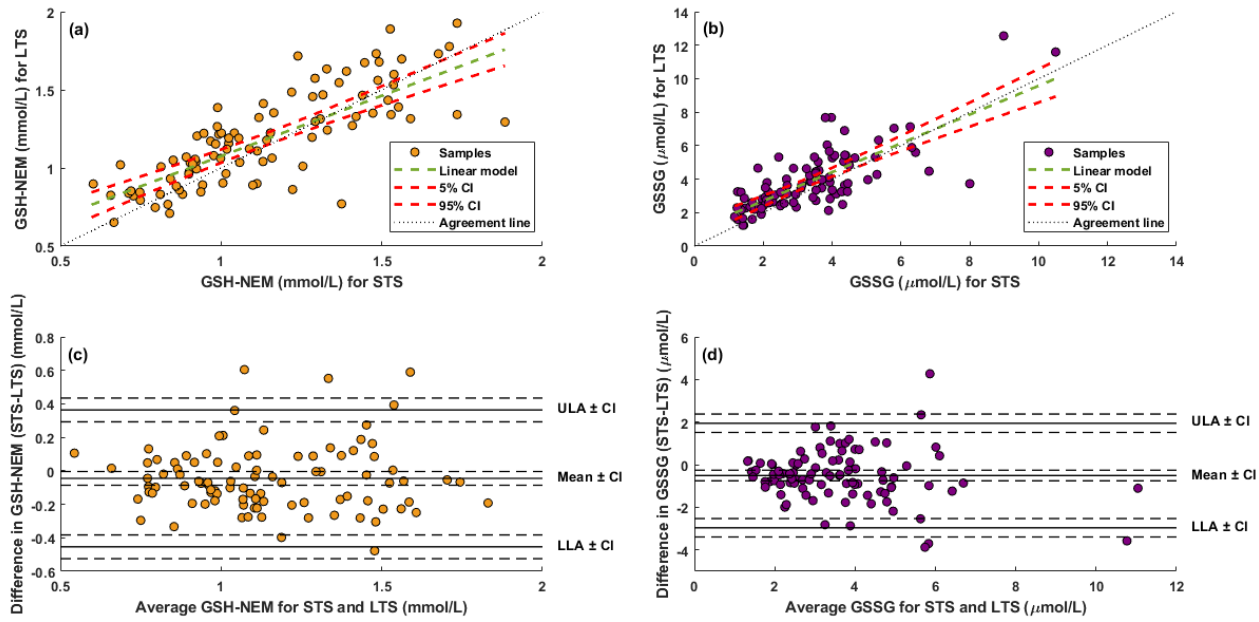
Figure 6. Regression line between GSH-NEM ( a ) and GSSG ( b ) concentrations measured under short- and long-term storage conditions (STS and LTS, respectively). Bland–Altman plot for GSH-NEM ( c ) and GSSG ( d ) comparing STS and LTS conditions. Note: CI, 95% confidence interval; LLA, lower limit of agreement; ULA, upper limit of agreement.